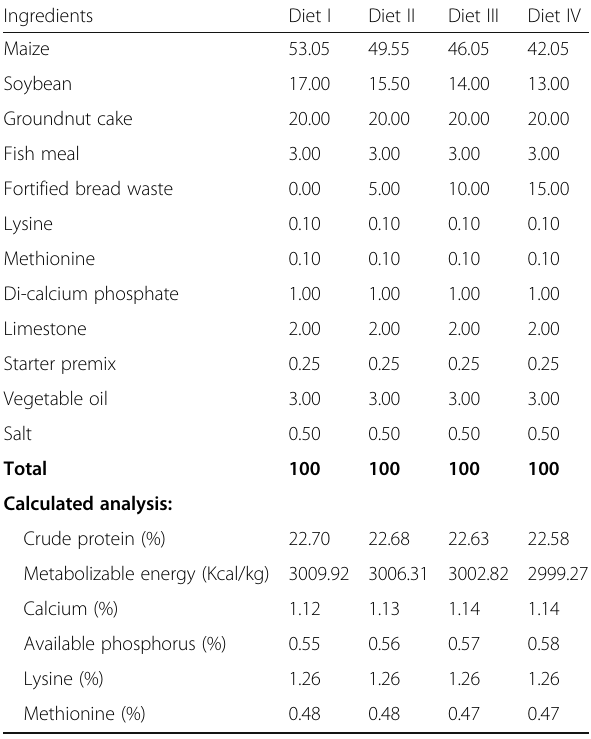
Table 2 Gross composition of the starter diets